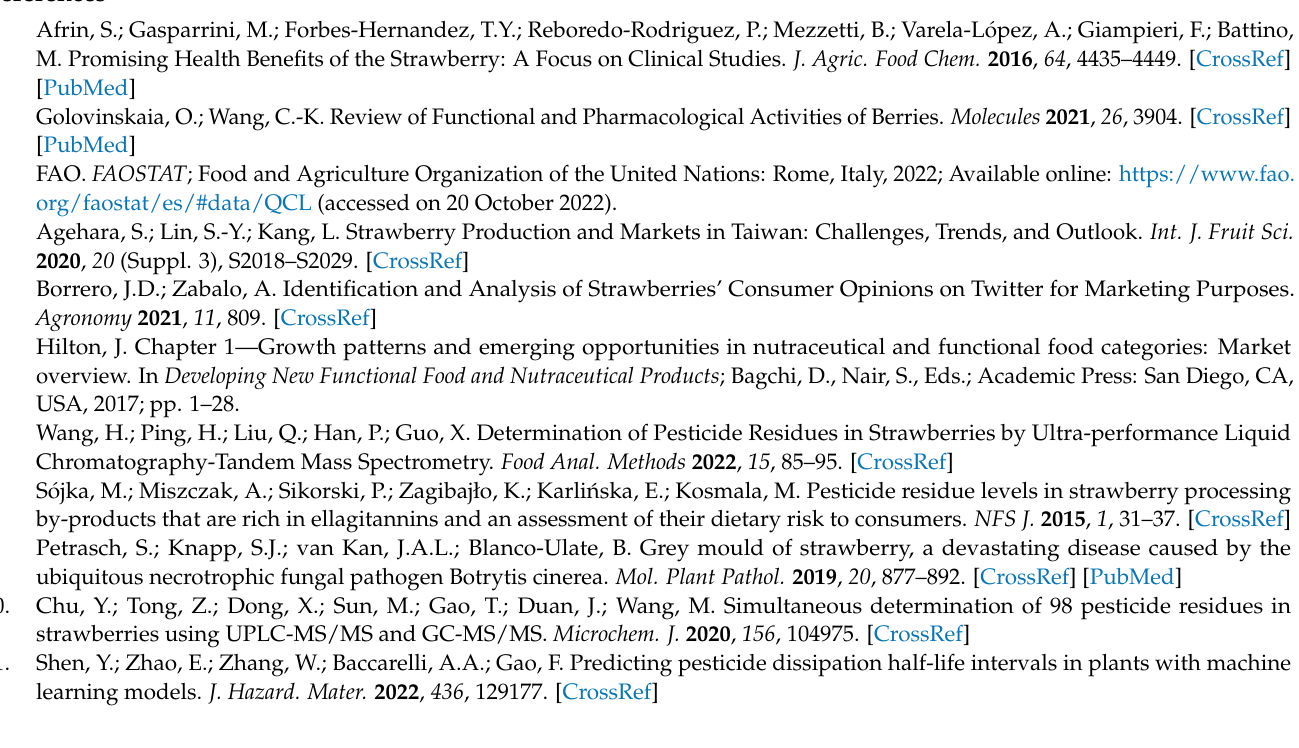
linearity of matrix effect of strawberry fruit. Figure S3. System Linearity. Table S1. Conditions of MS/MS. Table S2. Evaluation of the Chi square statistic for repeatability. Table S3. Analysis of variance for one factor with random effects. Table S4. Method accuracy. Table S5. Equations for calculate the LOD and